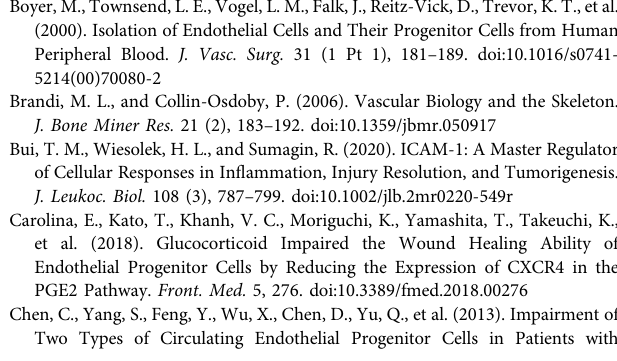
Abbreviations:ICA,icariin;BMECs,bonemicrovascularendothelialcells;LPS,lipopolysaccharide;MPS,methylprednisolone;eNOS,endothelialnitricoxidesynthase;SOD2,superoxide dismutase2;RASA1,Rasp21proteinactivator1;THA,totalhiparthroplasty;vWF,vonWillebrandfactor;PDGF-B,platelet-derivedgrowthfactor-B;Bax,Bcl-2,associatedX;Bcl-2,Bcell lymphoma-2;EPCs,endothelialprogenitorcells;Dex,dexamethasone;AMPK,AMP-activatedproteinkinase;LKB1,liverkinaseB1;mTOR,mammaliantargetofrapamycin;Nrf2,nuclear factor erythroid 2-related factor